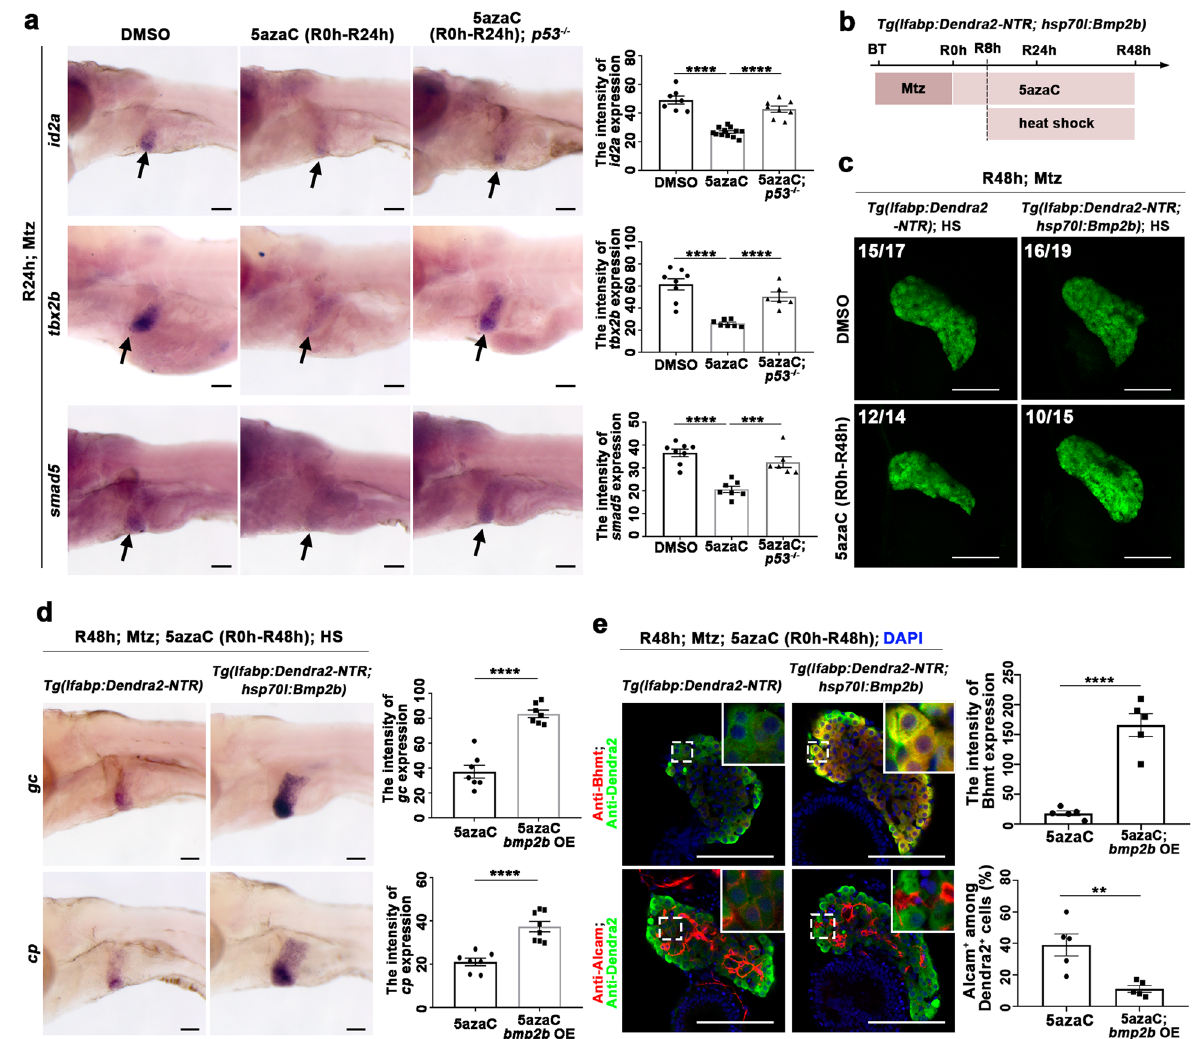
Fig. 6 Late DNA methylation inhibition activates p53 and in turn reduces BPPC redifferentiation through Bmp signaling. a WISH images showing the expressions of id2a, tbx2b , and smad5 at R24h treated with DMSO or 5azaC in p53 mutant and wild-type livers (arrows). Quanti fi cation of the intensity of id2a, tbx2b , and smad5 expressions in liver regions at R24h. Note that the expressions of id2a, tbx2b , and smad5 were recovered in p53 mutant compared with control after 5azaC treatment. b Experimental scheme illustrating the 5azaC and Mtz treatment in transgenic line Tg(lfabp:Dendra2-NTR; hsp70l:Bmp2b) and heat shock from R8h to R48h. c Confocal images showing the regenerating livers at R48h after heat-shock and 5azaC treatment. d WISH images showing the expressions of gc and cp at R48h after heat- shock and 5azaC treatment. Quanti fi cation of the intensity of gc and cp expressions in liver regions at R48h. e Single-optical section images showing the expressions of hepatocyte marker Bhmt and BECs marker Alcam at R48h after heat-shock and 5azaC treatment. Quanti fi cation of the intensity of Bhmt expression and the percentage of Alcam + among Dendra2 + cells in liver regions at R48h. Asterisks indicate statistical signi fi cance: ** P < 0.01; *** P < 0.001; **** P < 0.0001 using t -tests analysis when compared to control. Numbers indicate the proportion of larvae exhibiting the expression shown. Scale bars: 100 µm; error bars, ±SEM. DAPI 4 ′ ,6-diamidino-2-phenylindole, BT before treatment, HS heat shock, OE overexpression, R regeneration time after the withdrawal of